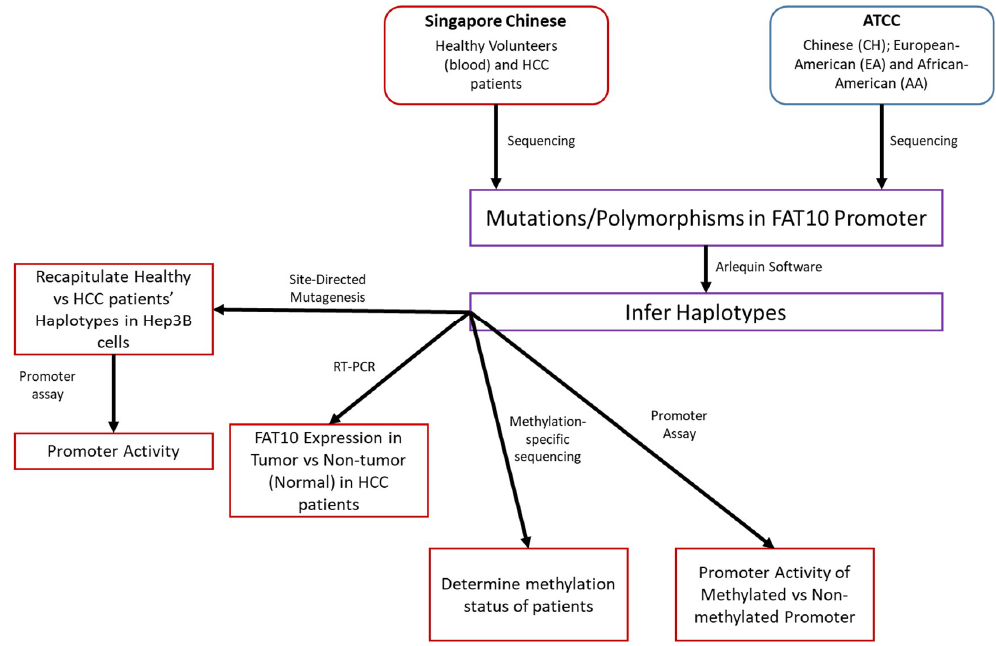
Figure 1. Study Design. Workflow of the project is presented, including the source of the patient samples and the techniques employed.